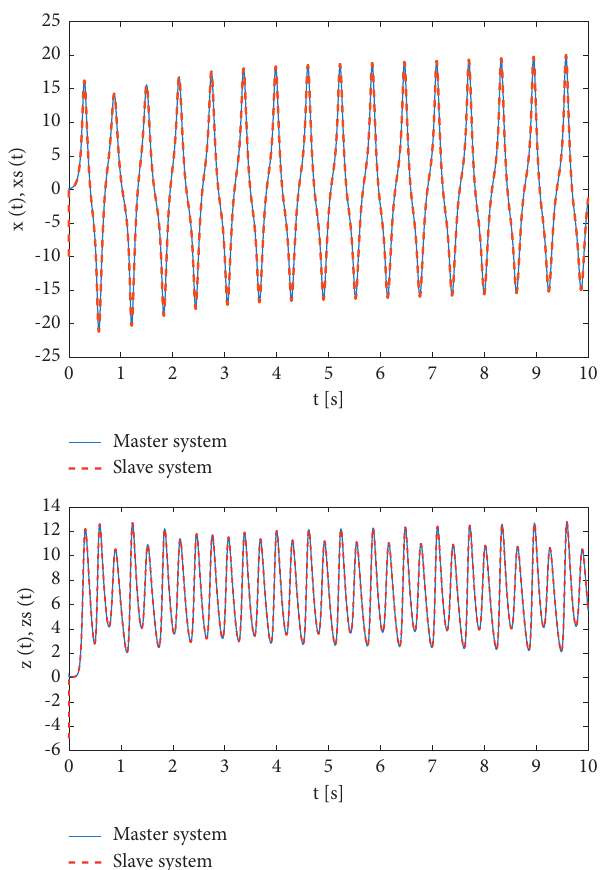
Figure 12: Some of the time series graphs of synchronized